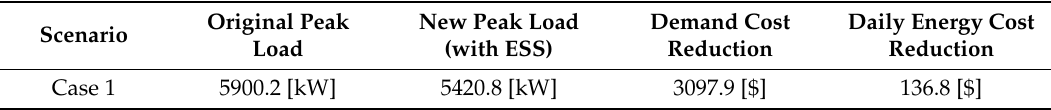
Figure 9. Case 1 simulation results. ( a ) Comparison of the original load and the load after ESS operation; ( b ) ESS power; ( c ) State of charge (SOC). Table 9. Summary of Case 1 simulation results.